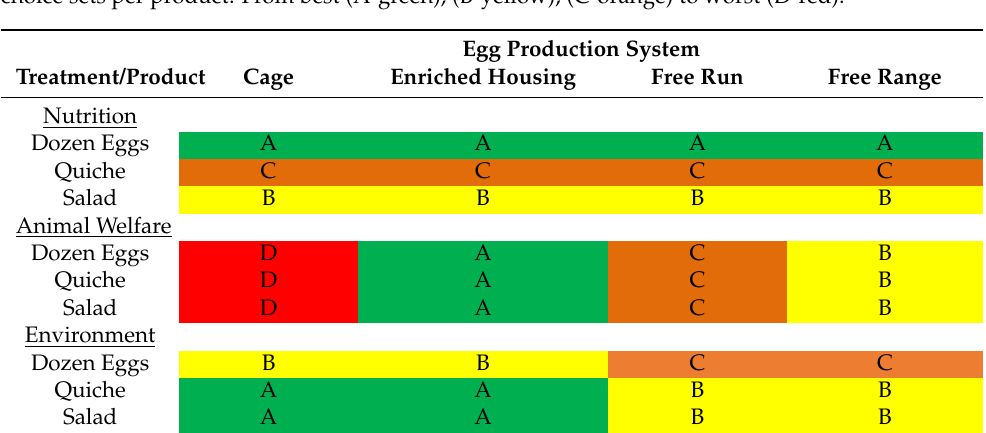
Table 2. Nutritional, animal welfare, and environmental scores attributed to each treatment in